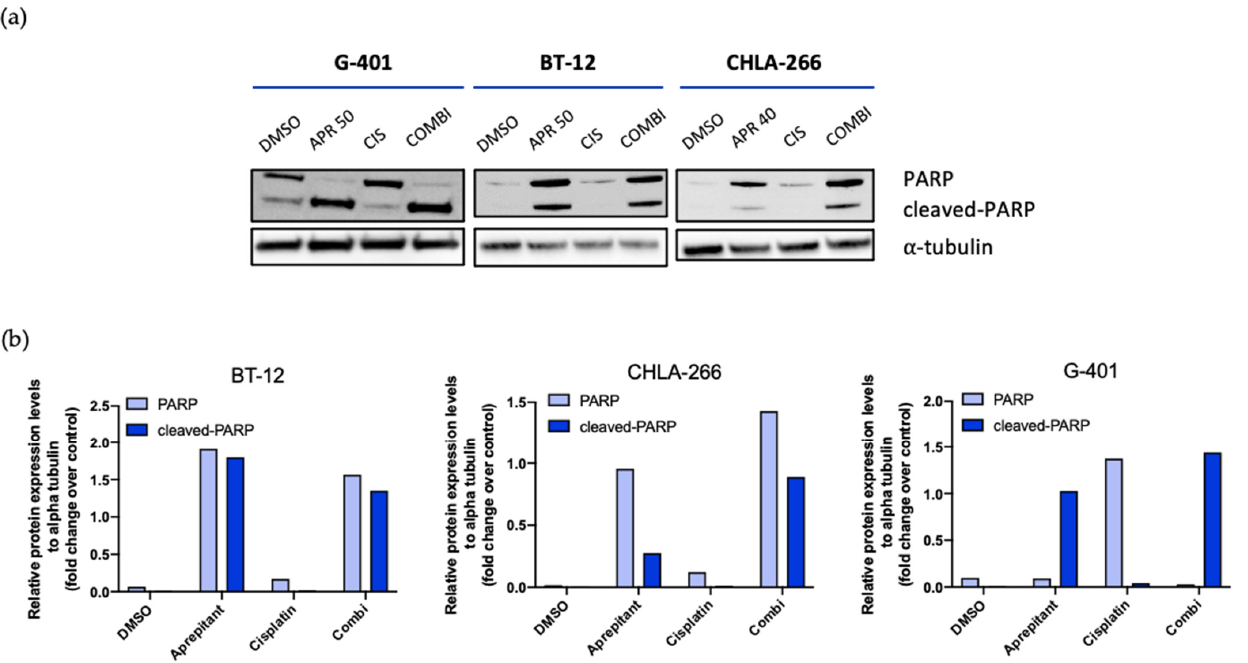
Figure 4. ( a ) Western blot analysis of G-401, BT-12 and CHLA-266 upon treatment with aprepitant (G-401 and BT-12, 50 µM; CHLA-266, 40 µM), cisplatin (CIS 20 µM) and aprepitant + cisplatin (COMBI) (48 h). DMSO used as a treatment control. Blots are representative of n = 2. ( b ) Densitometry analysis of Western blots. Relative protein expression levels were normalized to alpha tubulin expression.